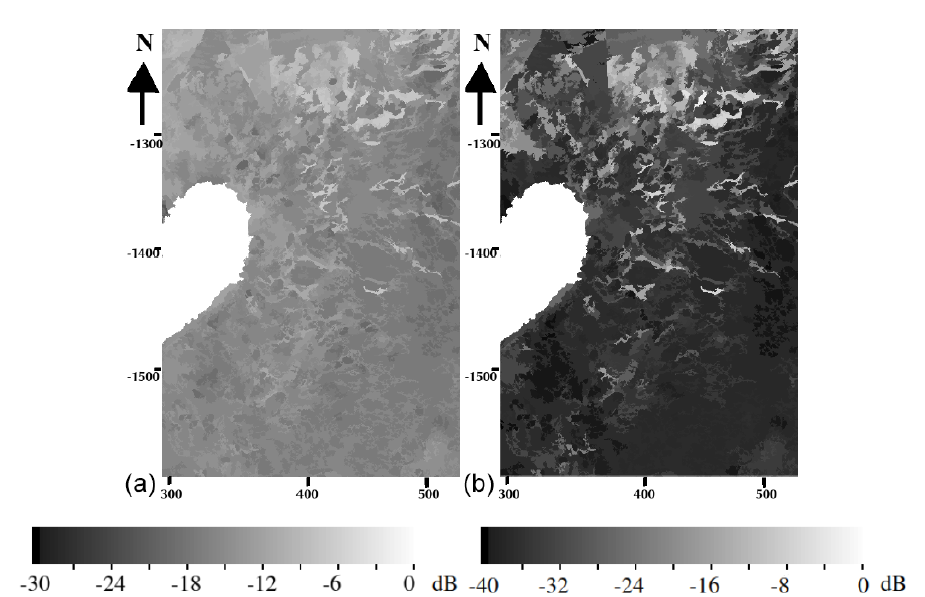
Figure 5. Cropped area of the HH (a) and HV (b) segment median images of Fig.